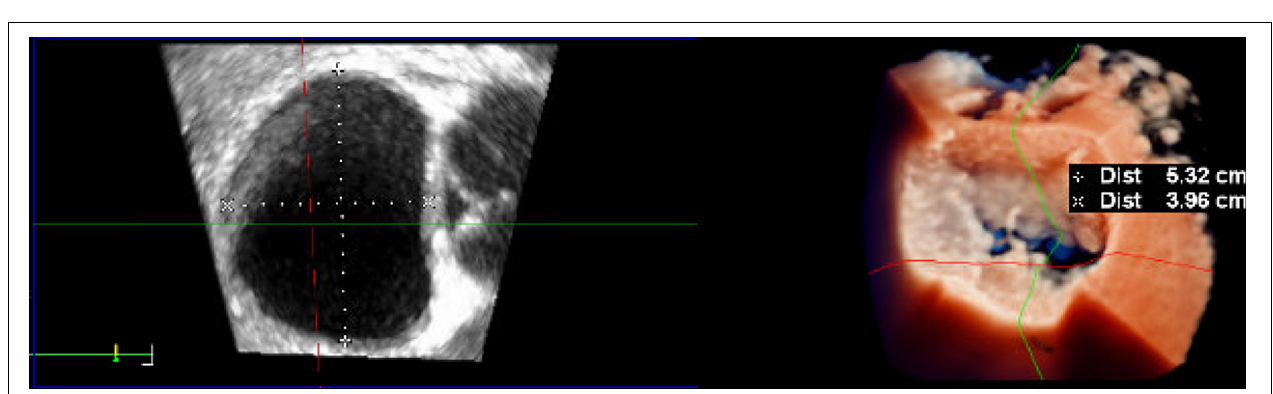
FIGURE 6 | Intraoperative three-dimensional TrueVue photo-realistic rendering of the mitral valve before repair with the HARPOON System. A surgical view of the atrial side of the mitral valve is shown on the right. The anteroposterior diameter of the mitral valve is 3.96 cm.